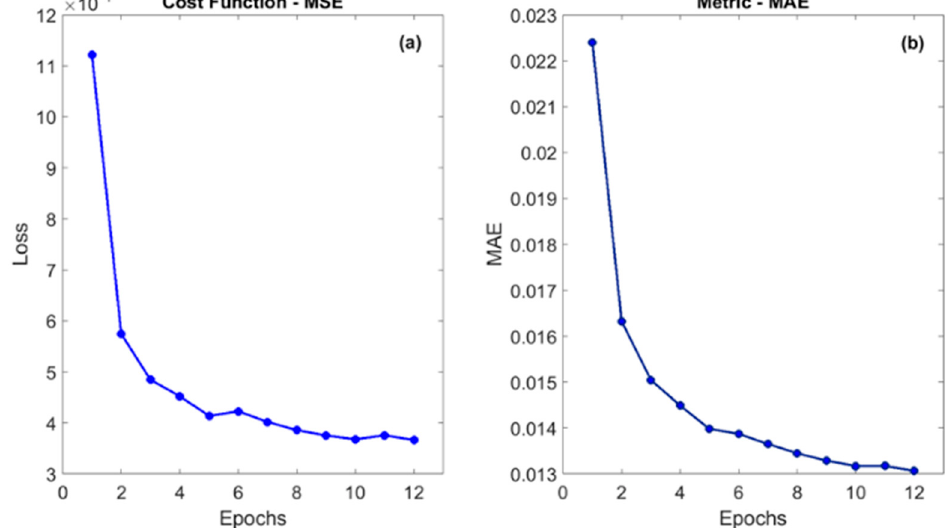
Figure 3. Panel ( a )— cost function (MSE) for day 365 of year 2014. Panel ( b )— metric (MAE) for the same day. According to the panels the convergence was reached after few epochs of training.